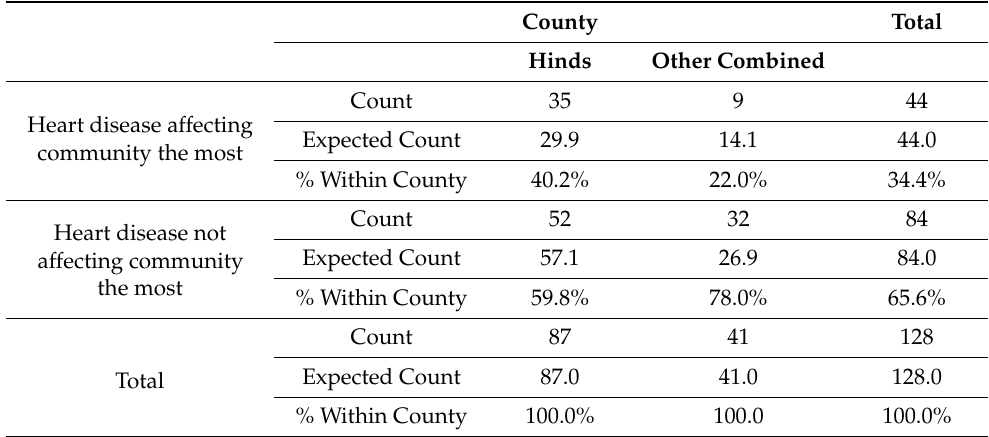
Table 18. Perceptions of Heart Disease Affecting Community the Most by County of